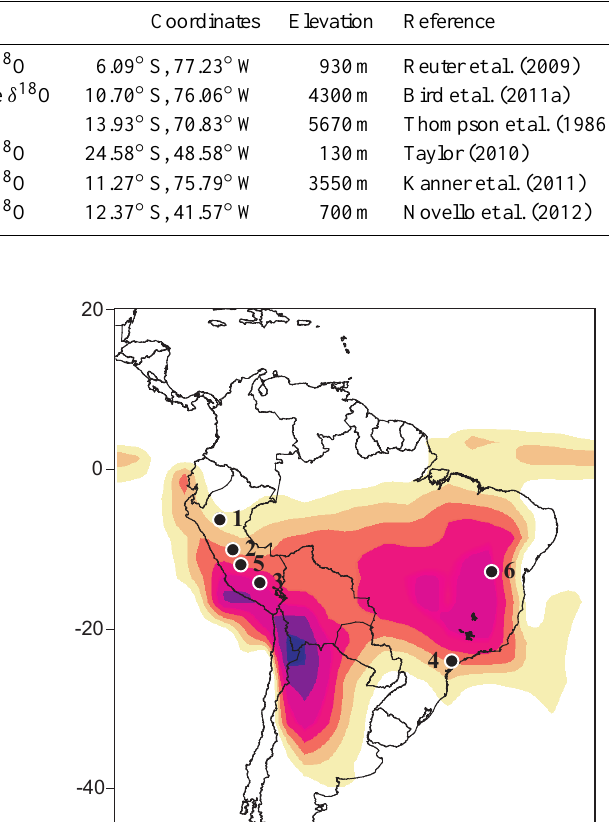
Table 1. High-resolution stable water isotope records in the South American monsoon domain.